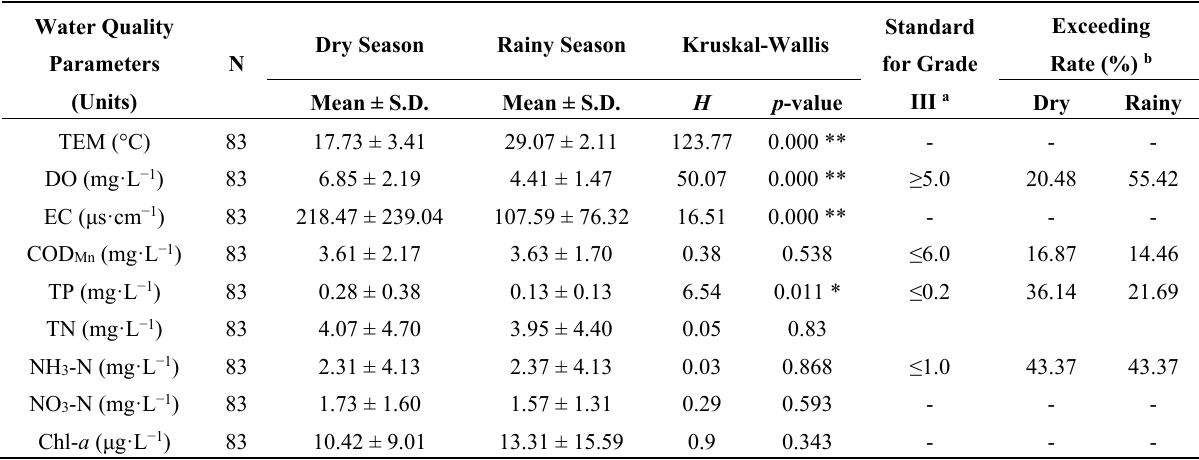
Figure 3. Spatial distribution of sampling site groups and land use types in the Dongjiang River basin. The sites were divided into three groups corresponding to forest-dominated sites (FDS), agriculture-dominated sites (ADS) and urban-dominated sites (UDS). Table 3. Summary of surface water quality between the dry and the rainy seasons in the Dongjiang River